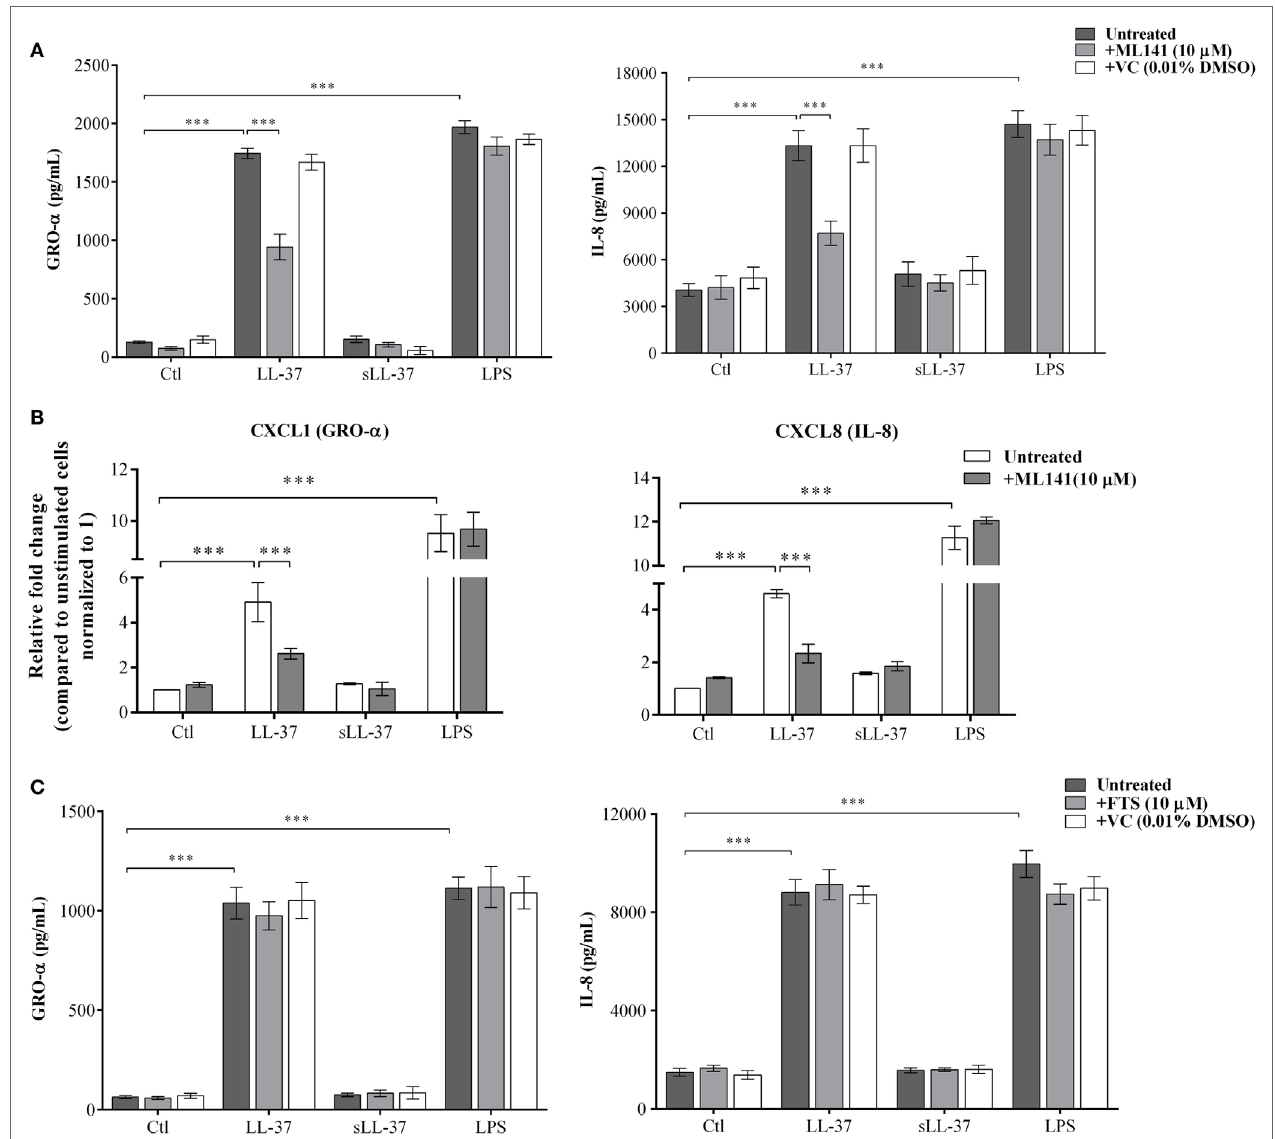
FigUre 1 | Cdc42/Rac1 GTPase controls LL-37-induced chemokine secretion. Macrophage-like THP-1 cells were pre-incubated with Cdc42/Rac1 inhibitor ML141 (10 µM) for 1 h, prior to stimulation with either LL-37 or sLL-37 (5 µM each), lipopolysaccharide (LPS) (10 ng/ml), or 0.01% DMSO as vehicle control (VC). (a) Tissue culture supernatants were monitored by ELISA for the production of chemokines GRO- α and IL-8 after 24 h. Results shown as mean ± SE of eight independent experiments ( n = 8). (B) mRNA expressions were evaluated by quantitative real-time PCR for chemokines ( GRO- α and IL-8 ) and anti-inflammatory cytokine IL-1RA , after 4 h. Relative fold changes were calculated compared to the expression in unstimulated cells, using the ΔΔ Ct method, after normalization with 18sRNA expression. Results shown as mean ± SE of three independent experiments. (c) Macrophage-like THP-1 cells were pre-incubated with the Ras inhibitor FTS (10 µM) for 1 h, prior to stimulation with either LL-37 or sLL-37 (5 µM each), or LPS (10 ng/ml). TC supernatants were monitored by ELISA for the production of chemokines GRO- α and IL-8 after 24 h. Results shown as mean ± SE of eight independent experiments ( n = 8). Analysis of variance with Bonferroni’s post hoc test was used for statistical analyses (*** p <